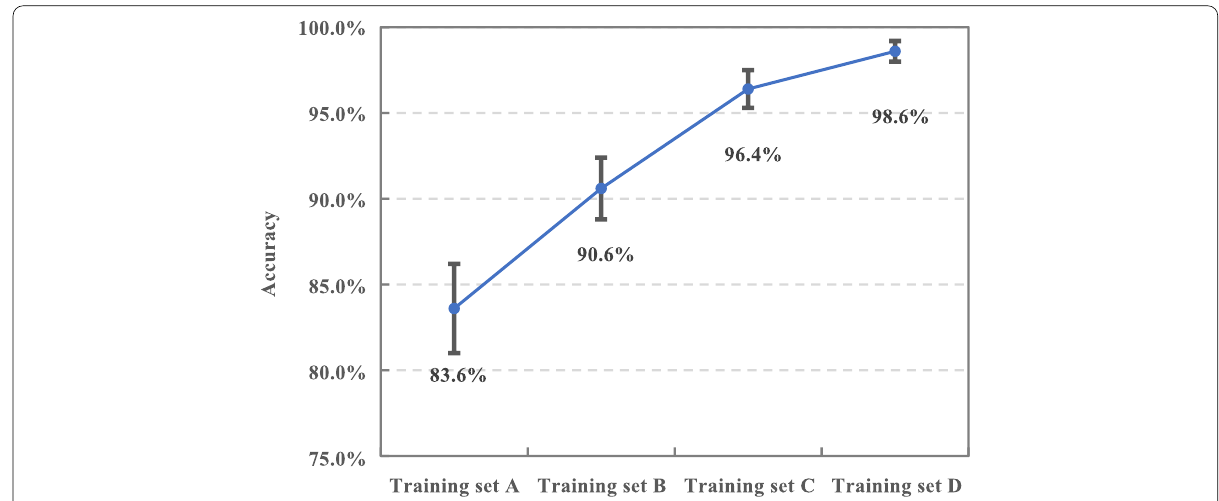
Fig. 9 Testing accuracy of ISNN using different training sets